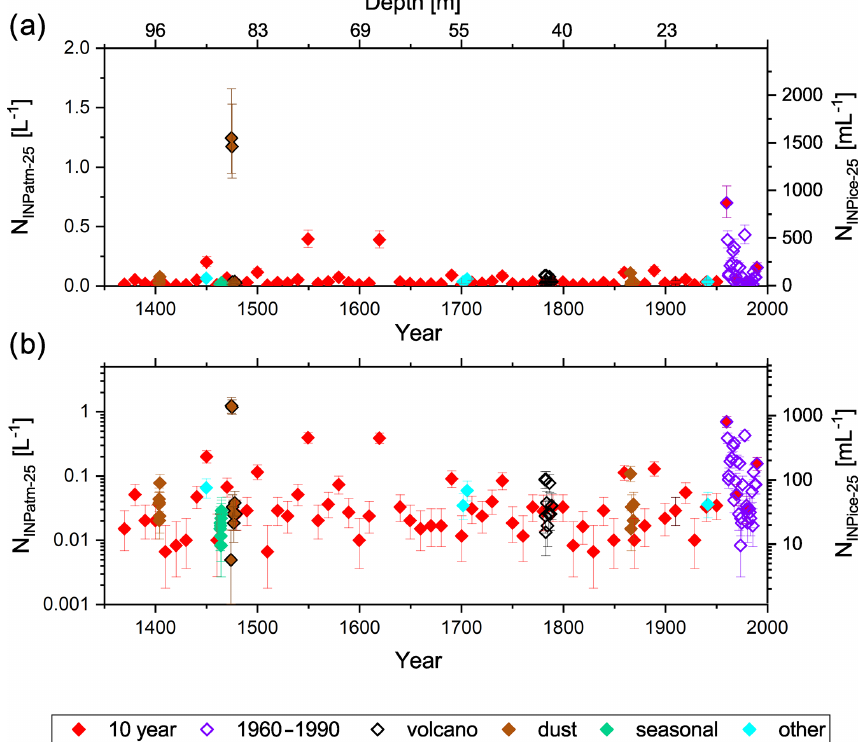
Figure 6. INP concentrations (right scale: per volume of ice; left scale: per volume of air) at − 25 ◦ C on both linear (a) and logarithmic (b) scales. Symbol colors correspond to the different sample groups as introduced in Fig. 1. The ice core’s (nonlinear) depth from the top is added for reference on the top x axis.